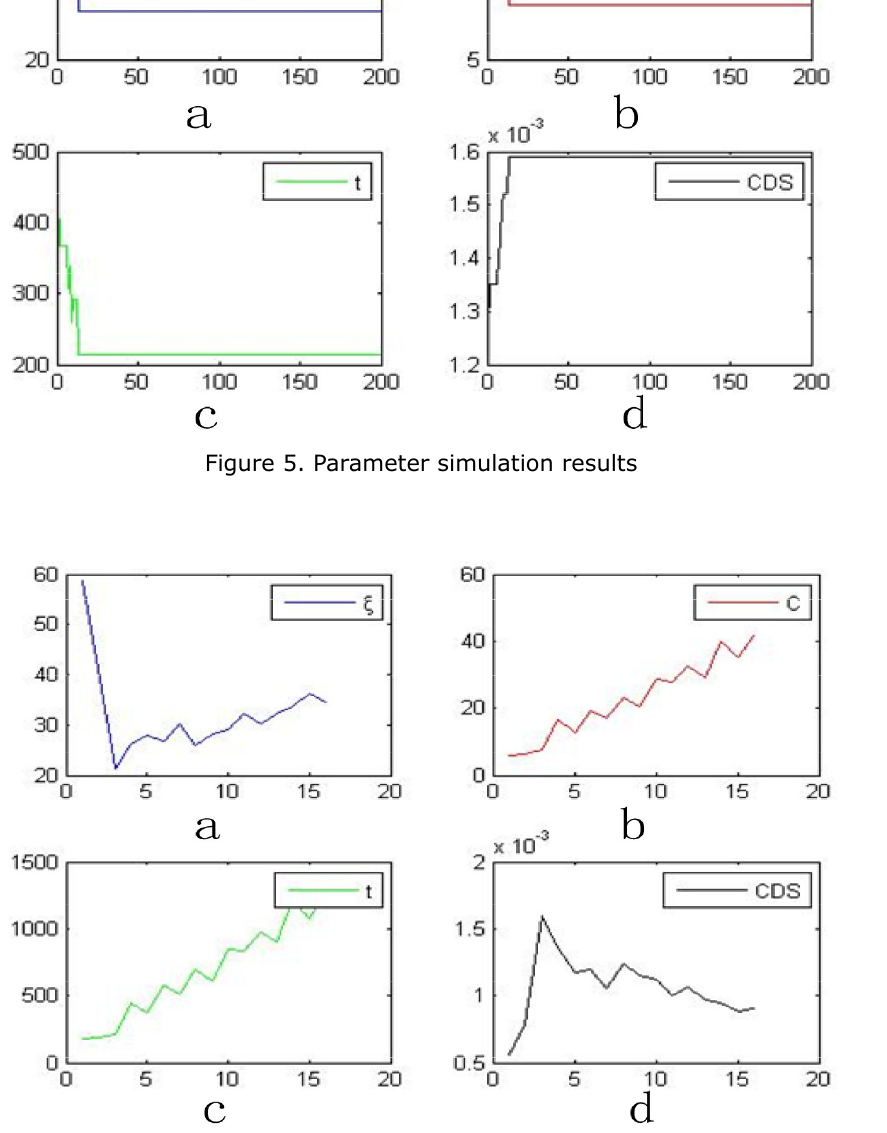
Figure 6. Relationship between quantity and